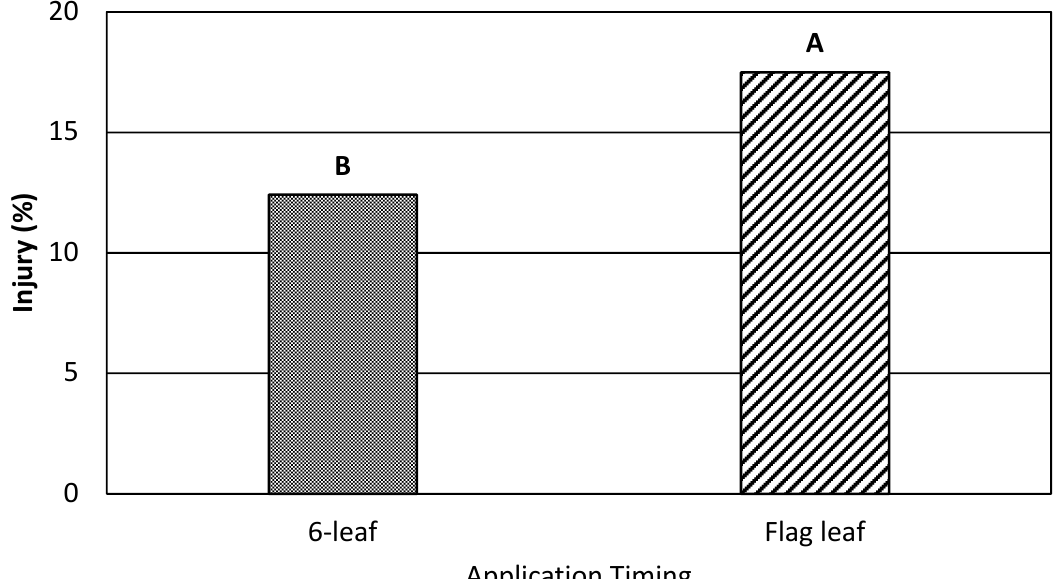
Figure 3. Grain sorghum injury from herbicide drifts at 14 DAA as affected by the application timing in 2017. Data were averaged over different herbicides used in this study. Same letters on bars indicate no significant differences at p < 0.05, according to Fisher’s least significant difference test.